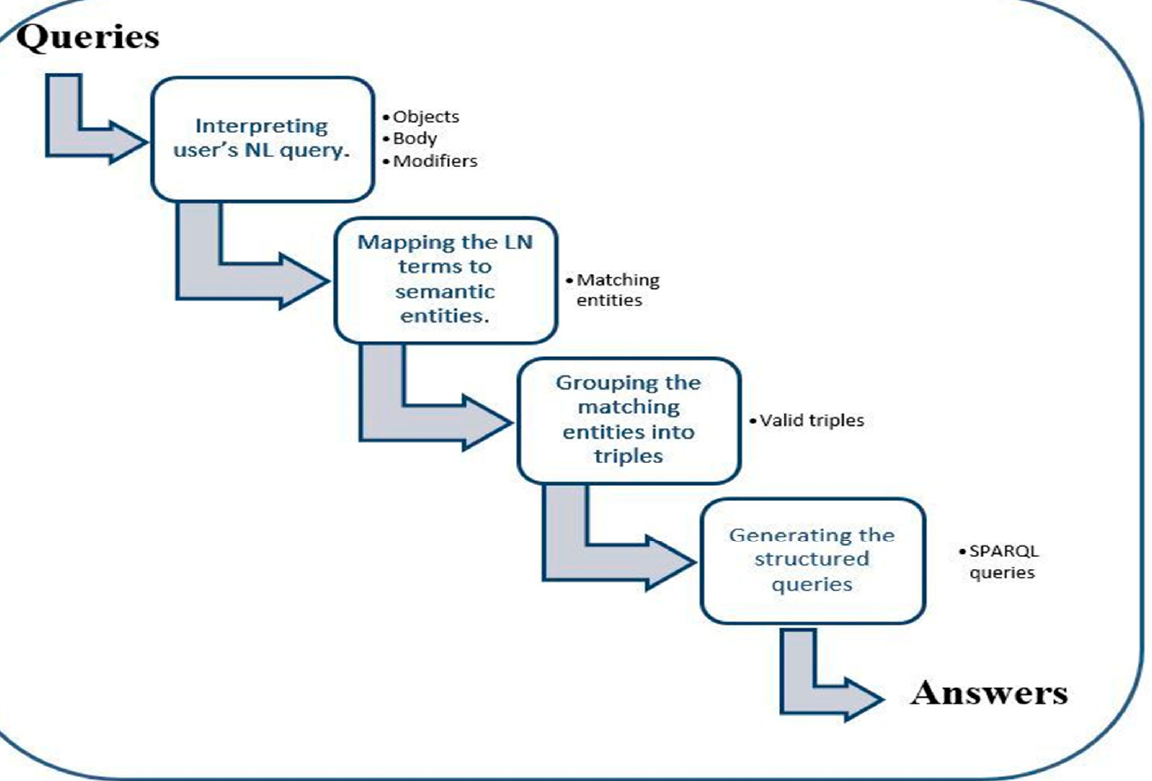
Figure 1. The proposed querying process.